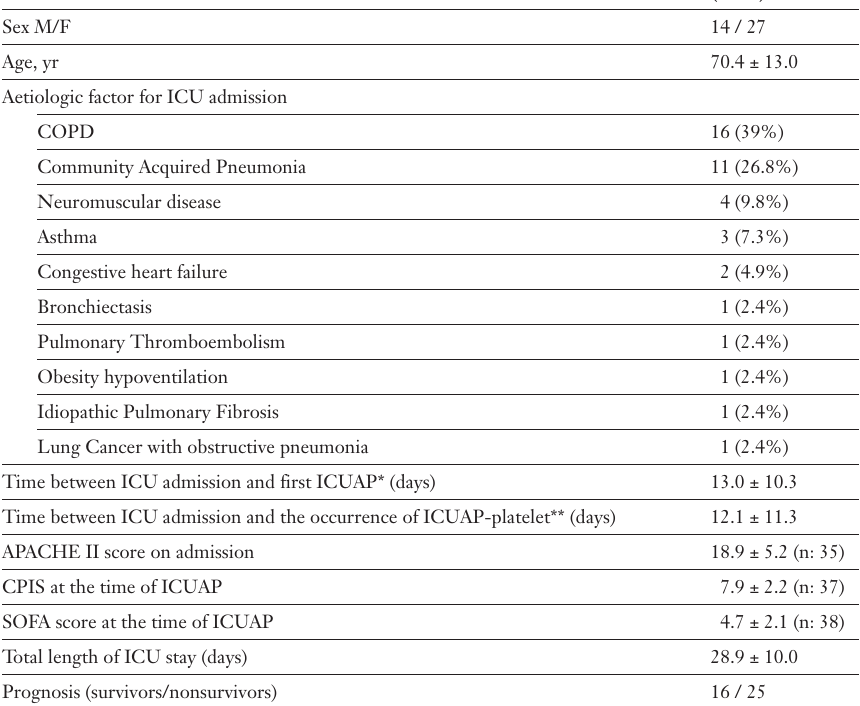
Patient characteris-